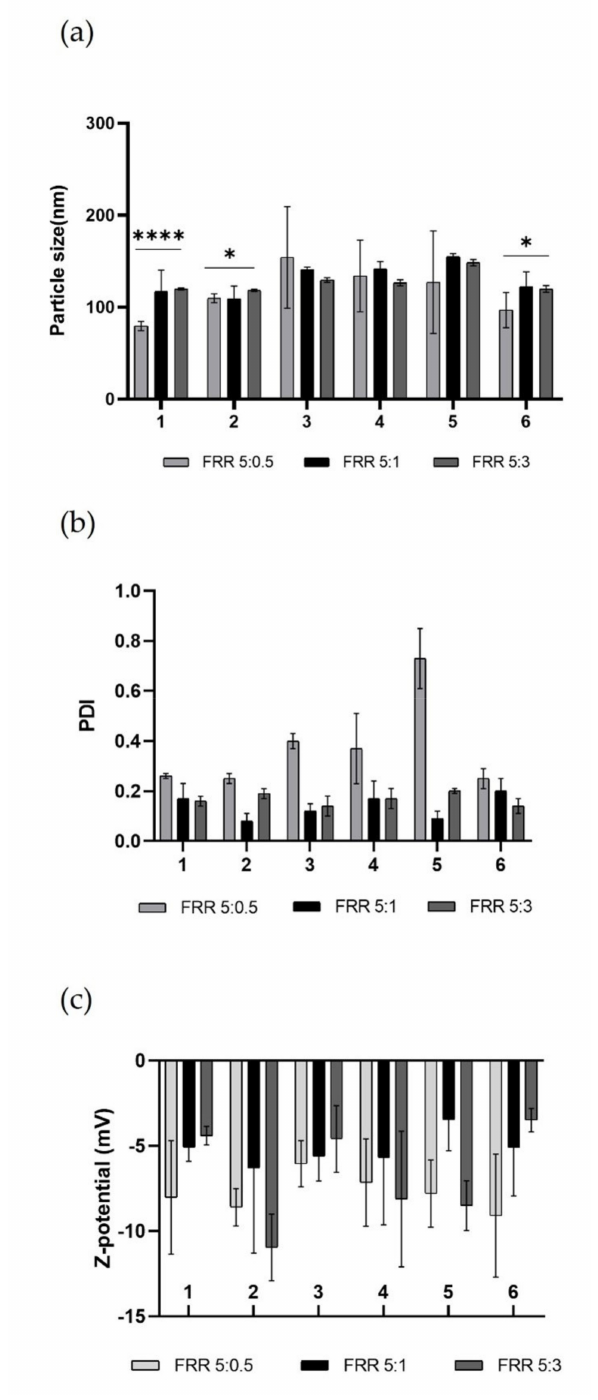
Figure 6. Representative graphs of empty LPs produced using DPPC/16:0 PEG2000 PE/Chol (2:2:1) in ethanol at total concentration 1mg mL − 1 . ( a ) Comparison of particle size (nm) of obtained LPs using different devices at several FRRs. To compare size, one-way ANOVA analysis was performed, adhering to a p value ≤ 0.05. In accordance with the results, comparing all devices for each FRRs, it was found that there was a significant difference (reported on the graph). Comparing each device for all FRRs, it was found that there was a significant statistical difference (****, p value < 0.0001) for device 1, while for device 2 and device 6 the statistical difference was modest (*, p value < 0.0332). ( b ) Comparison of PDI of obtained LPs using different devices at several FRRs. ( c ) Comparison of Z-potential (mV) of obtained LPs using different devices at several FRRs. Results represent mean ± SD, n = 3 independent